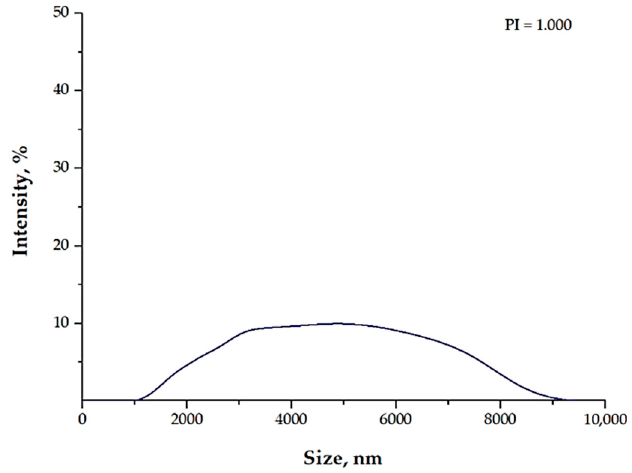
Figure 2. The size analysis of the particles in the suspension obtained as a result of the synthesis performed using the 1% Arabic gum solution.